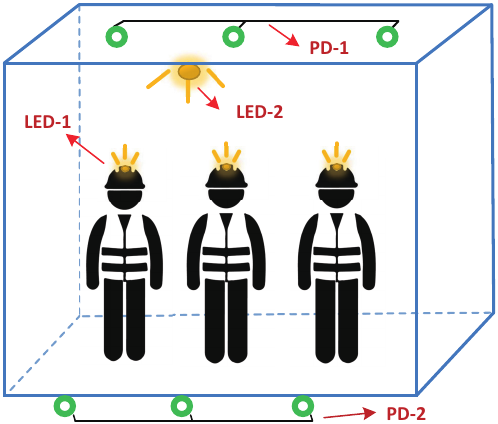
Figure 1. The usage scenario and the main idea of our